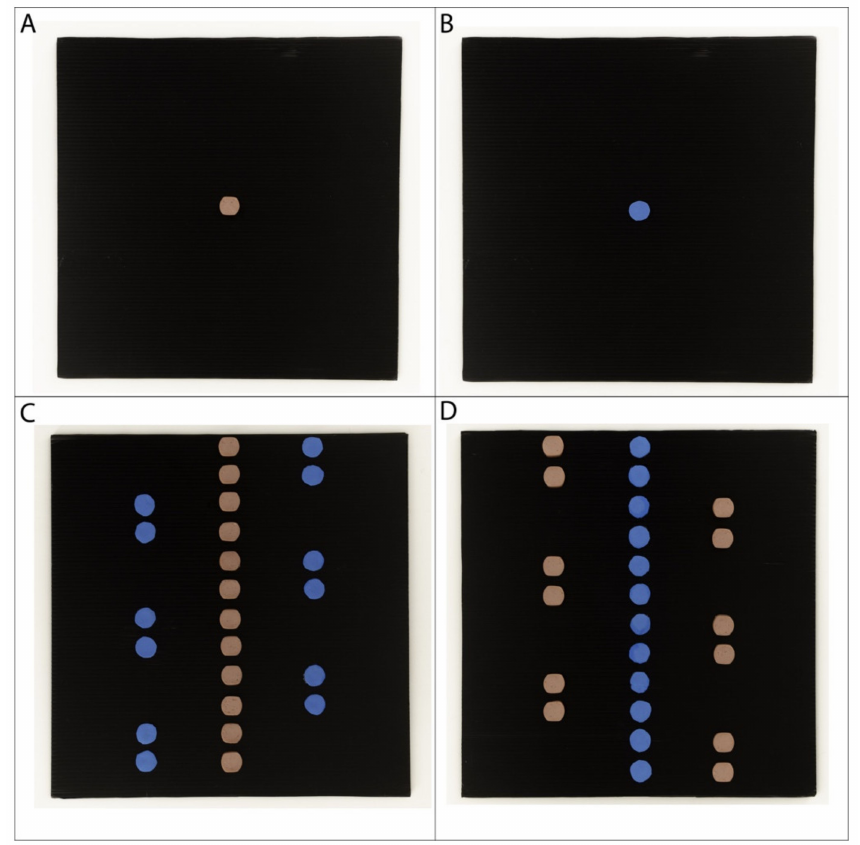
Figure 3. Photographs of the training stimuli ( A , B ) and the test stimuli ( C , D ) of Experiment